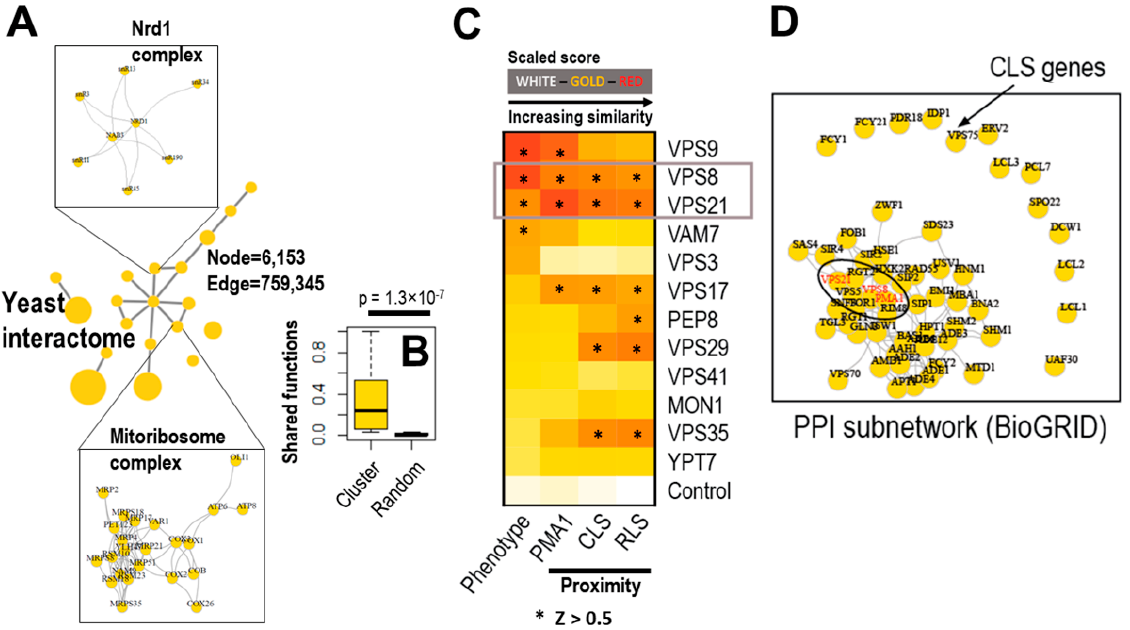
Figure 6. A systems biology approach reveals that Vps8p and Vps21p interact with various proteins involved in CLS and RLS. The systems biology approach identified key drivers of the aging process, such as VPS8 and VPS21 . ( A ) Yeast protein interaction networks are generated from the BioGRID database (6153 nodes and 759,345 edges). This shows protein clusters of the protein interaction networks (nodes are protein clusters, and edges are significant interactions between clusters). The top box indicates protein interactions of the corresponding clusters, which are enriched with the Nrd1 complex proteins. The bottom box shows protein interactions of the corresponding clusters, enriched with the mitoribosome complex proteins. ( B ) Proteins in clusters share molecular functions (i.e., GO functions), significantly more than randomly-selected proteins (Wilcoxon test p -value = 1.3 × 10 − 7 ). ( C ) Based on network proximity measures, the 12 screened genes (rows of the heatmap) are signifi- cantly connected with PMA1 (second column), CLS (third column), and RLS genes (fourth column). Based on a scaled score (Z-score > 0.5), VPS8 and VPS21 are significantly higher on all occasions, likely being critical players in the aging process. The leftmost columns in the heatmap indicate phenotype changes in the 12 screened genes. ( D ) VPS8 and VPS21 are centrally located at the CLS interaction network, thereby governing the interactions of CLS